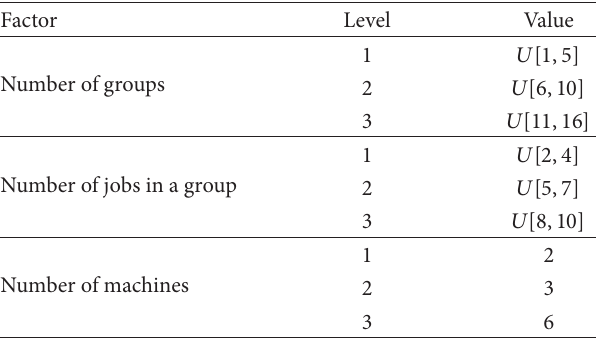
Table 1: Benchmark of instances for the FDSGSLE